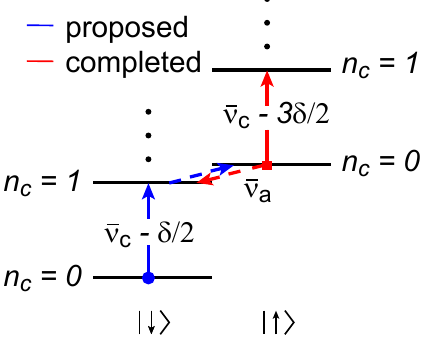
Figure 6. Lowest cyclotron, spin and axial levels of an electron in a Penning trap, including small shifts due to special relativity. Separate transitions driven for our completed measurement are in red. For the new measurement, we propose to drive the transitions in